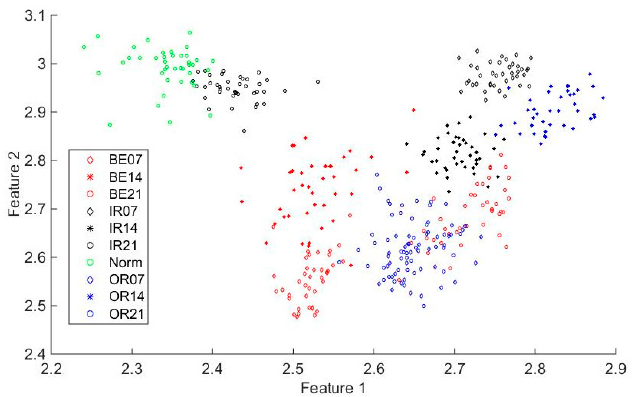
Figure 12. Two dimensions of the IMAAPE feature vectors for different fault types under different fault diameters with the load 0 hp.